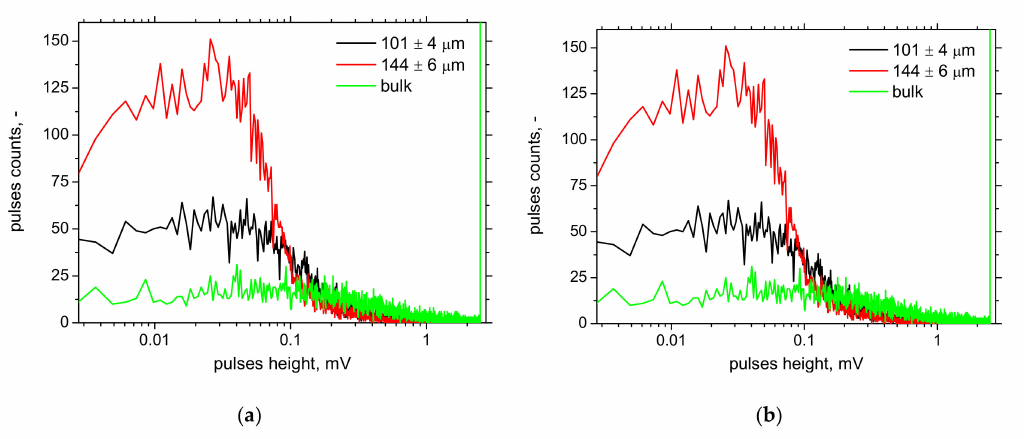
Figure 13. Distribution of MBN pulses height. ( a ) RD, ( b ) TD. It should be considered that MBN originates from the diffusion layer and the under- lying untouched matrix. The phase diagram drawn according to Schramm [29] indicates that the matrix is fully composed of the Γ phase as soon as the Zn exceeds approx.